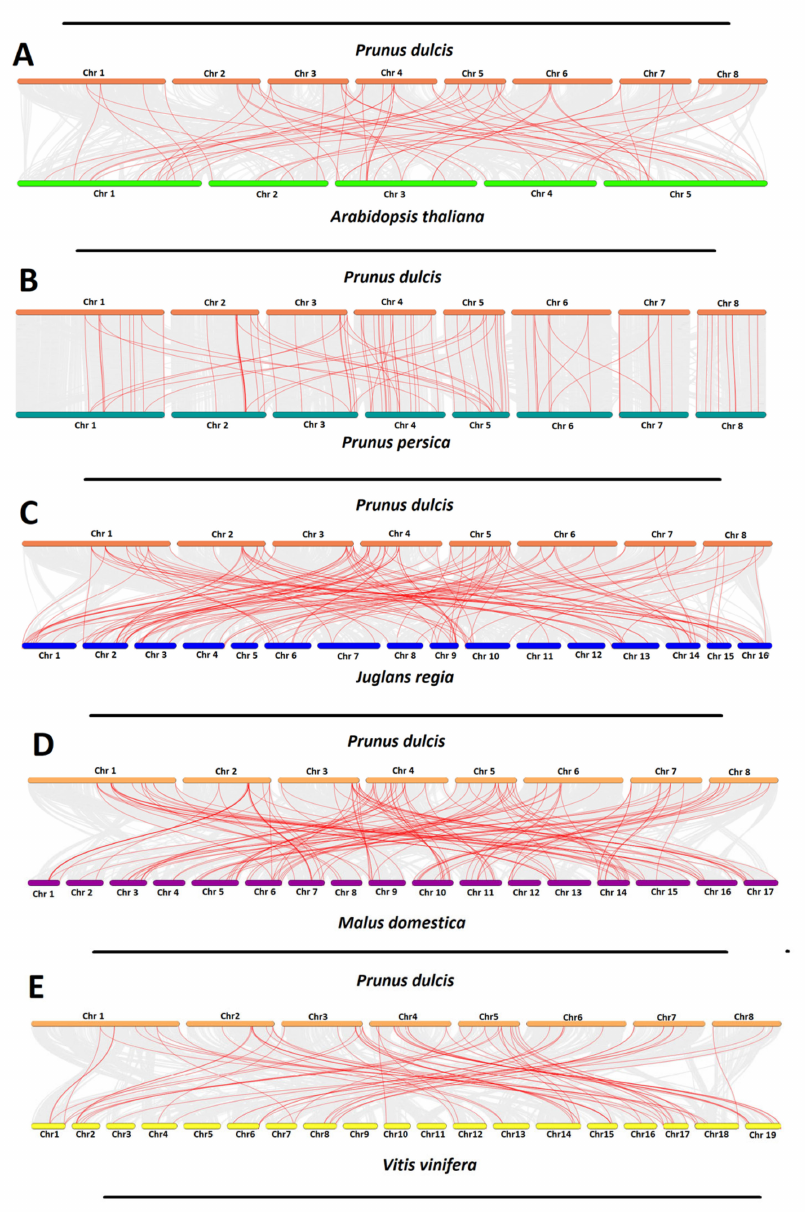
Figure 7. Visualization of the syntenic analysis. Synteny of the P. dulcis NAC has been visualized with the NAC of A. thaliana ( A ), P. persica ( B ), J. regia ( C ), M. domestica ( D ), and V. vinifera ( E ). Red lines between the genomes show the synteny between the